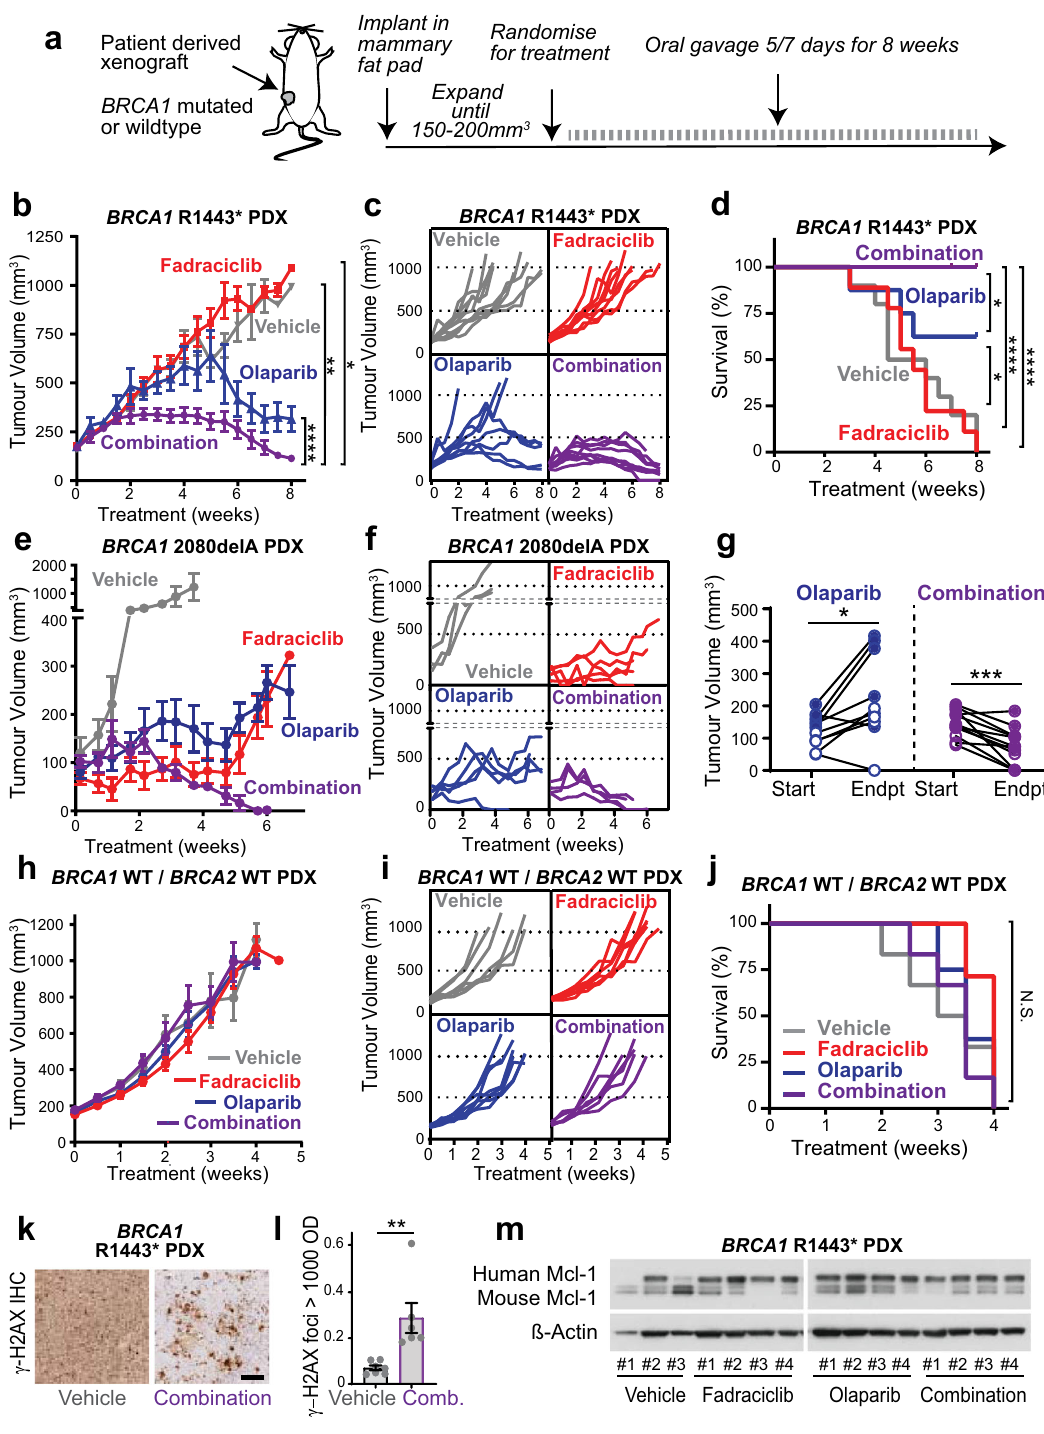
receptor (PR), HER2 status, and mutation status of BRCA1 , BRCA2 , CHEK2, and PALB2 . CK5/14 and/or EGFR positive tumors were classi fi ed as BLBC, while CK5/14 and EGFR negative tumors were classi fi ed as non-basal like breast cancer (NBLBC). Dual-color in situ hybridization (ISH) assay for detection of the 19q12 locus ampli fi cation A 19q12 DNP ISH probe that covers the coding sequences of the CCNE1 and adjacent URI1 genes and an INSR DIG ISH probe, a surrogate